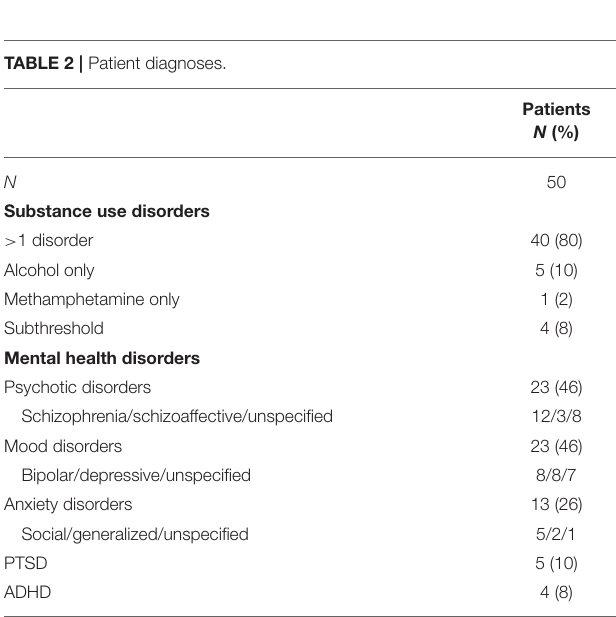
TABLE 2 | Patient diagnoses.